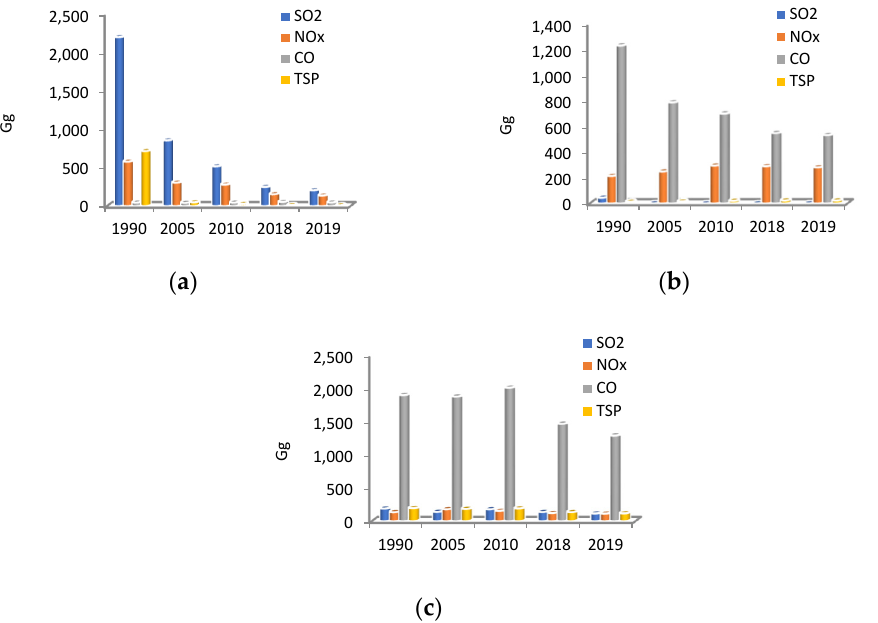
Figure 3. ( a ) energy industry; ( b ) transportation; ( c ) other sectors; where: TSP—total suspended particles.